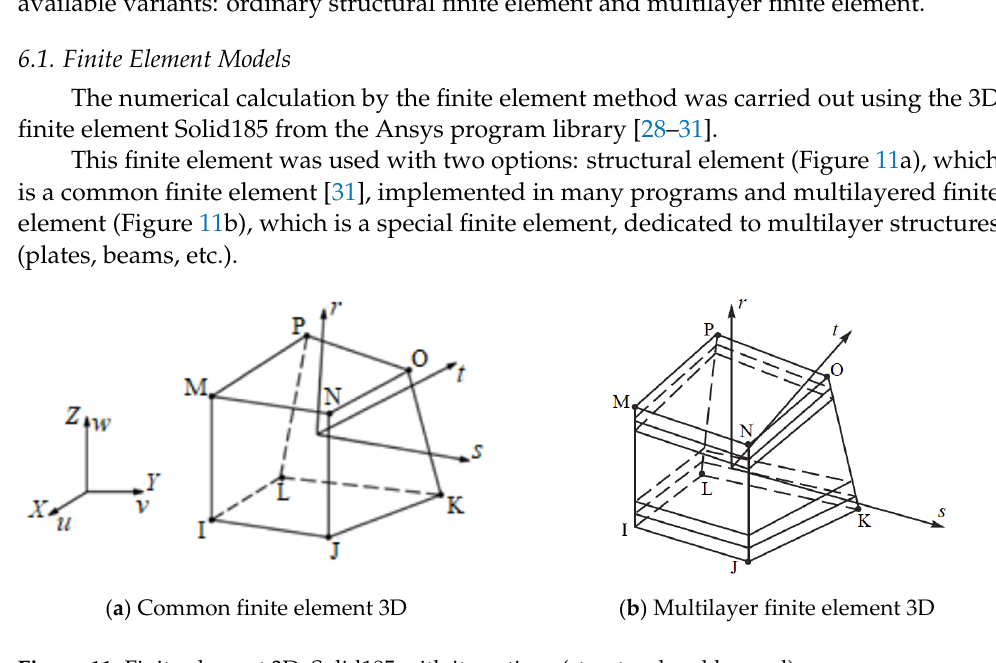
Figure 11. Finite element 3D, Solid185 with its options (structural and layered).